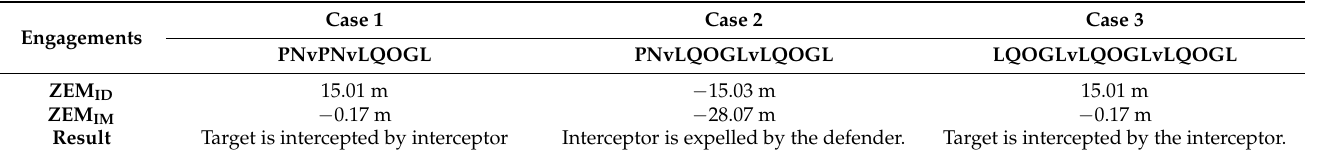
Table 2. Simulation